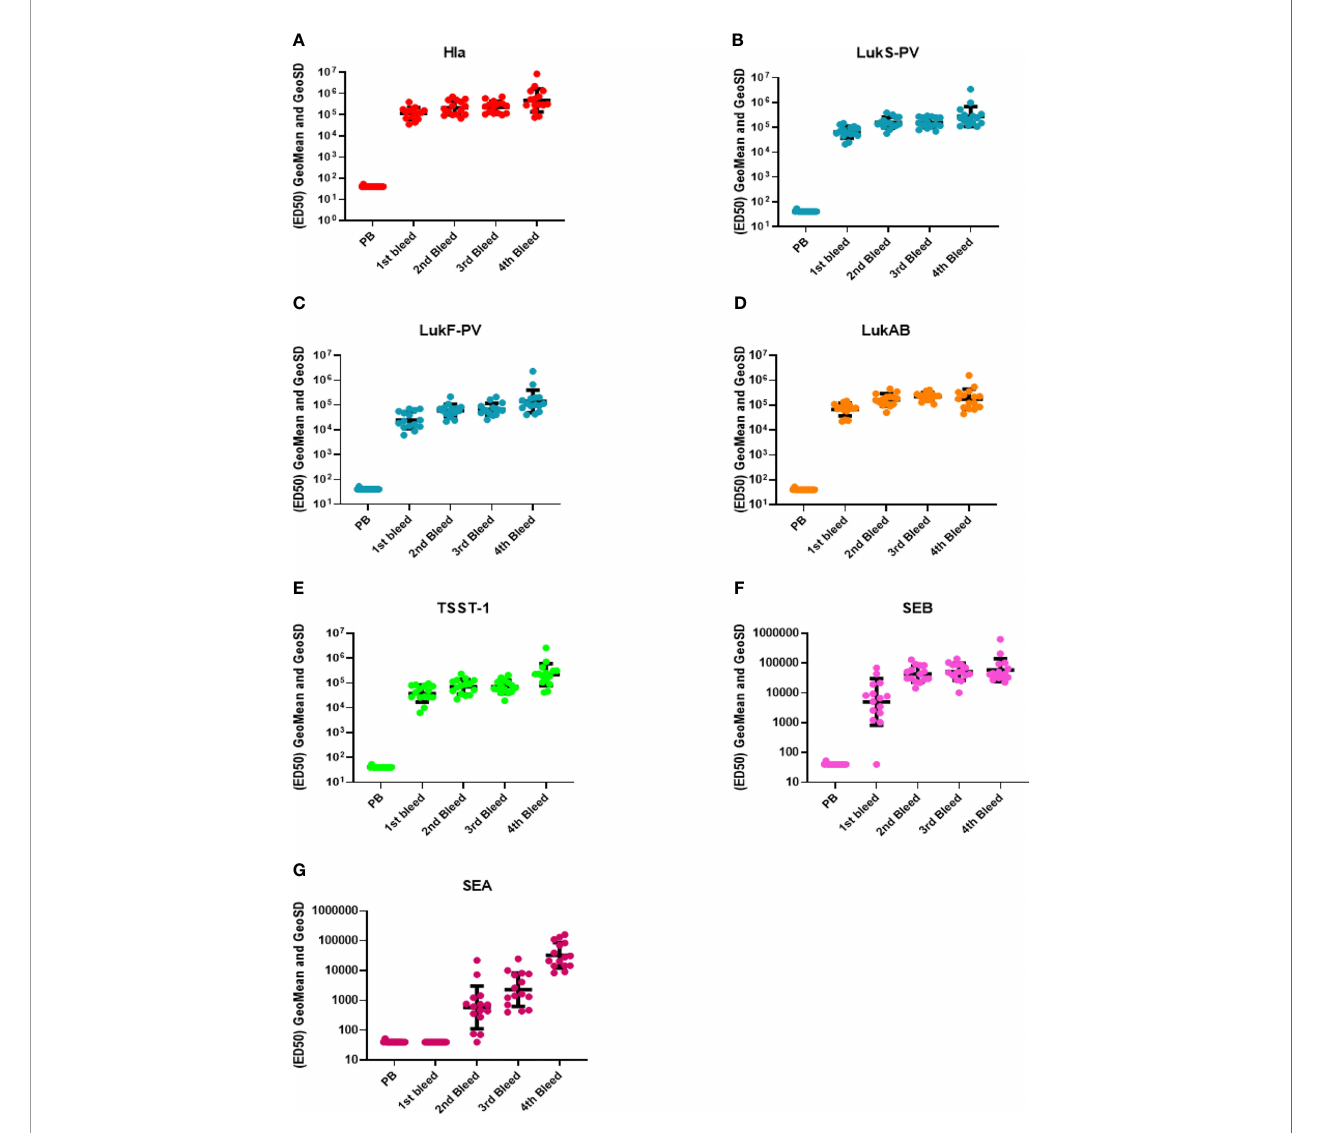
FIGURE 2 | Antibody titers during rabbit immunization. The 50% effective dilution (ED 50 ) for the antigen binding determined by the Luminex assay whereby 50% of antigen was detected by toxin-speci fi c antibodies present in the serum sample, was measured in the pre-bleed (PB) and three test bleeds along with the fourth and fi nal terminal bleed (refer to Figure 1 ). Toxin components are (A) Hla, (B) LukS-PV, (C) LukF-PV, (D) LukAB, (E) TSST-1, (F) SEB, and (G) SEA. Geomean values (black lines) were plotted along with